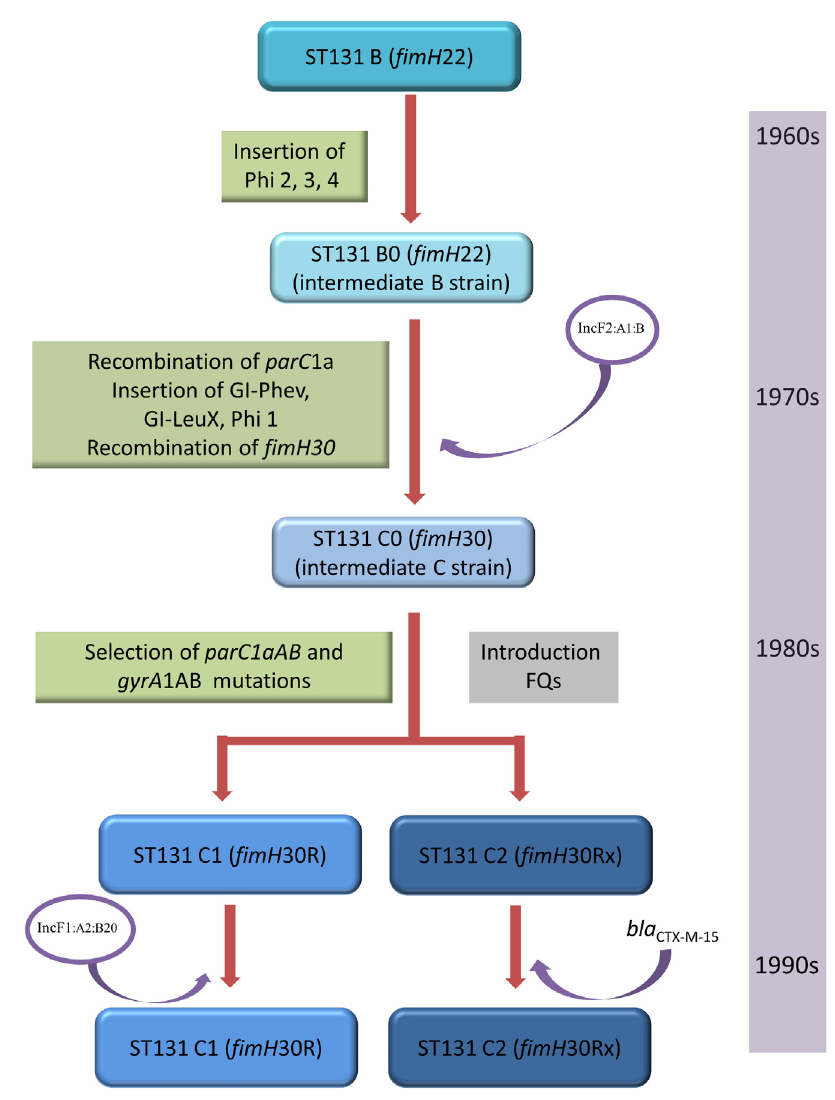
Figure 1. Stepwise evolution of Escherichia coli ST131 clades B, B0, C0, and C. FQ, fluoroquinolones; GI, genomic islands; Inc, incompatibility; Phi, prophages; ST, sequence